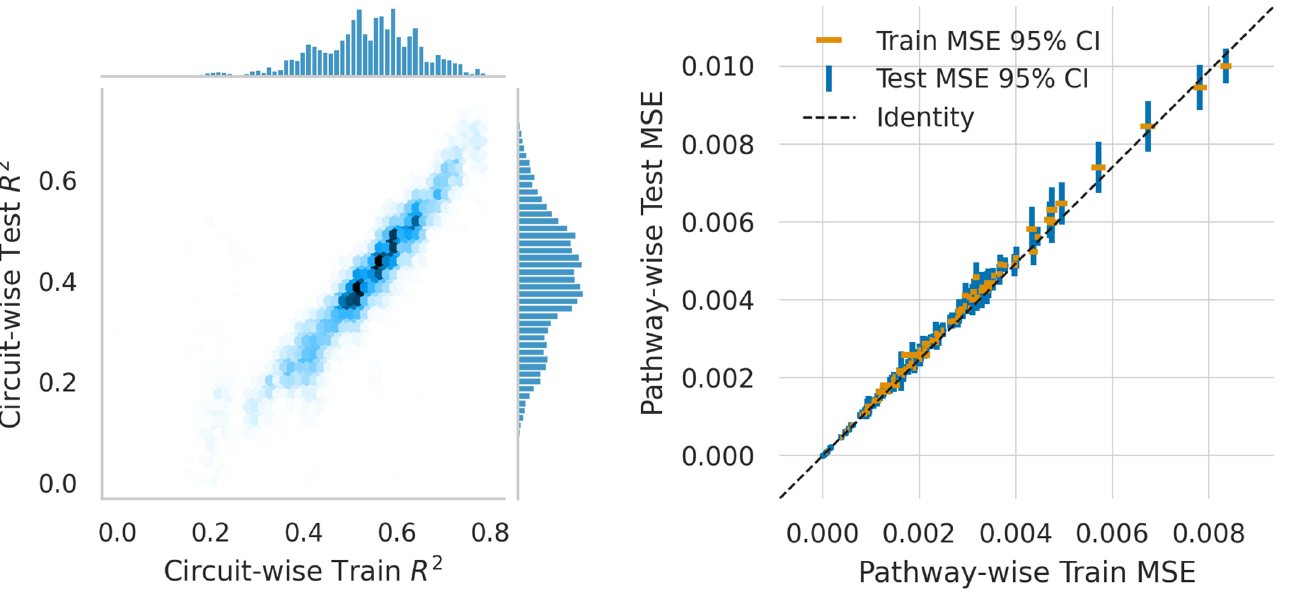
Figure 1. Machine learning method performance. Left: Joint distribution plot of the task-wise R 2 for the train and test folds. Right: MSE , averaged for each signaling pathway.